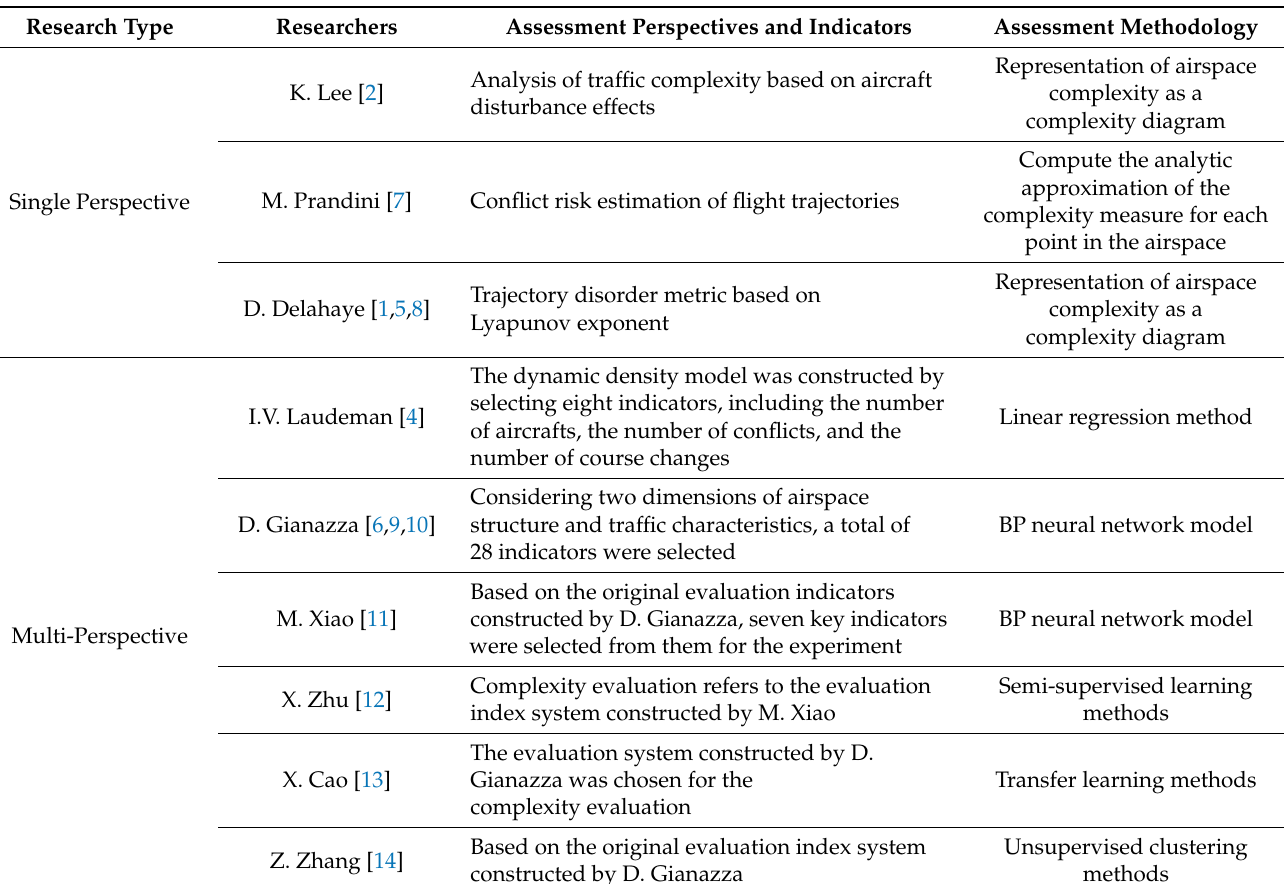
Table 1. Representative studies of air traffic